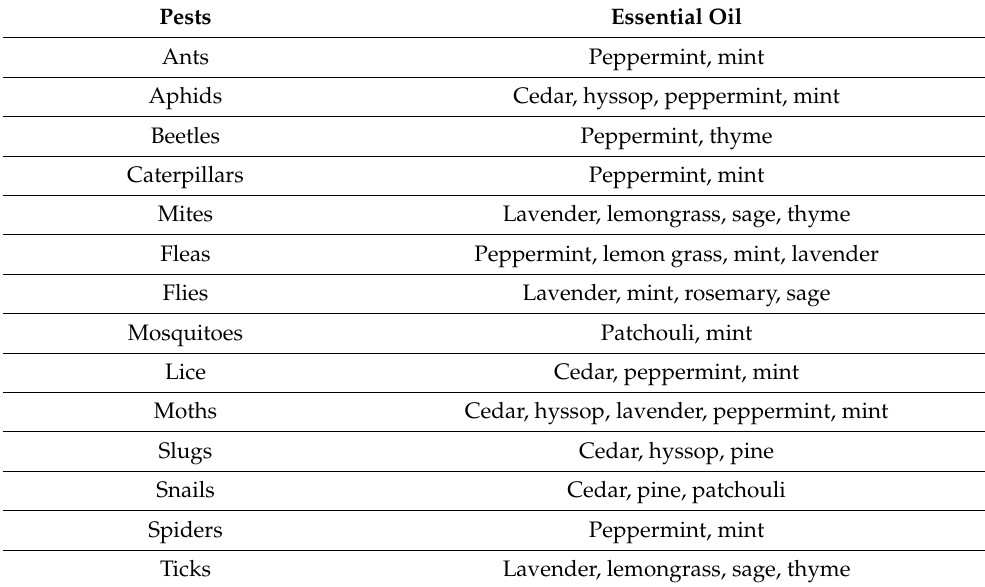
Table 5. Pests/pesticides and their corresponding essential oil